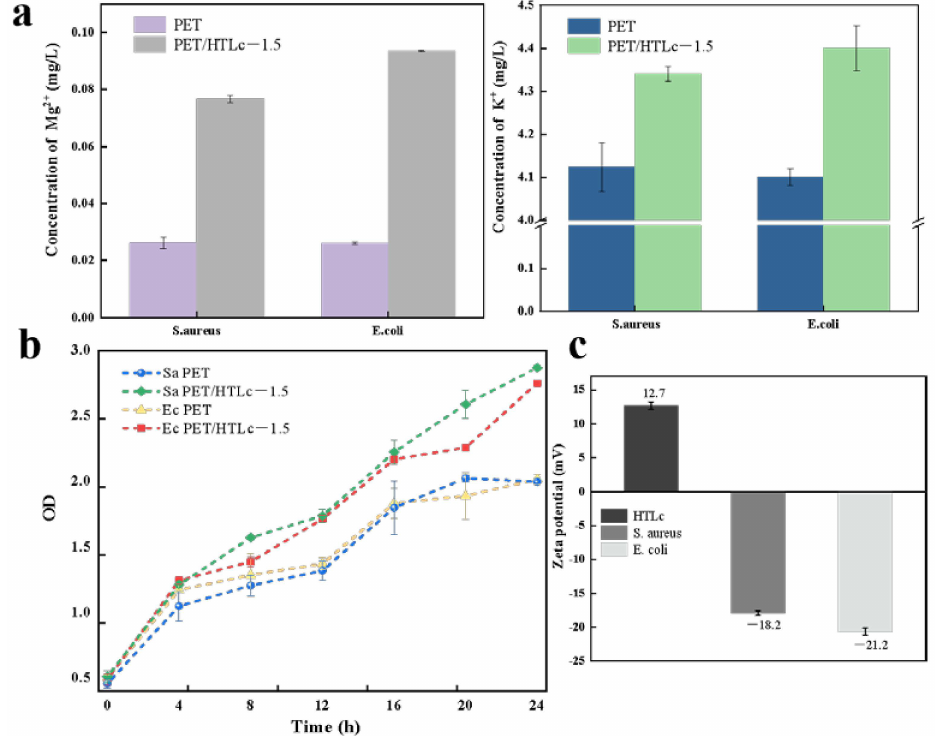
Figure 6. Bacterial inhibition mechanism of PET/HTLc-1.5 film: ( a ) Effect of PET/HTLc-1.5 on the extracellular Mg 2+ , K + content of S.aureus and E.coli . ( b ) Effect of PET/HTLc-1.5 on the extracellular protein content of S. aureus and E. coli . ( c ) z -potentials of HTLc, S. aureus and E. coli